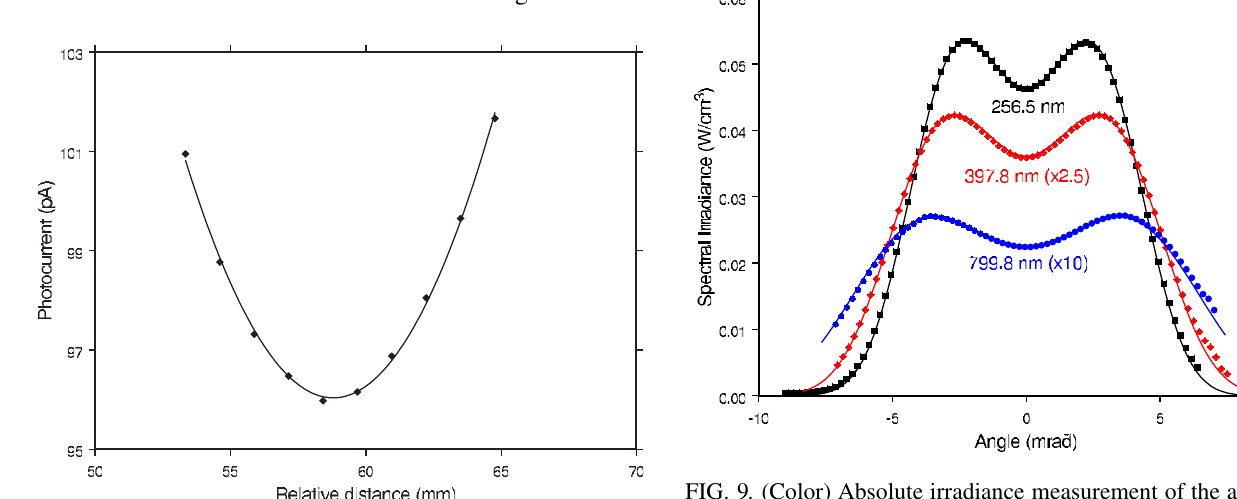
FIG. 9. (Color) Absolute irradiance measurement of the angular distribution of synchrotron radiation at a SURF energy of 380 MeV. All results are normalized to 1 mA of SURF III current with the top curve measured at 256.5 nm using FR1 followed by 397.8 nm using FR2, and 799.8 nm using FR3. The lines are the results of calculations using Schwinger’s